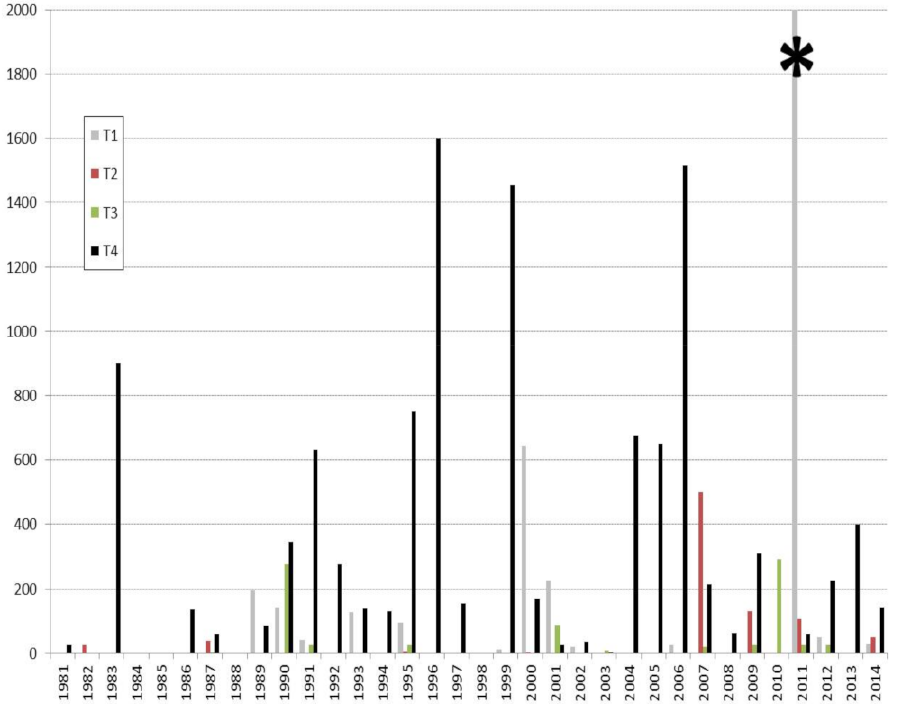
Figure 1. Quarterly die-off reports attributed to Aspergillosis in North-American avifauna. (USGS 1981–2014). T1: January to March; T2: April to June; T3: July to September; T4: October to December. * To improve the clarity of the diagram, an episode that occurred in 2011 associated with a very high mortality rate (7000 dead) is not represented in